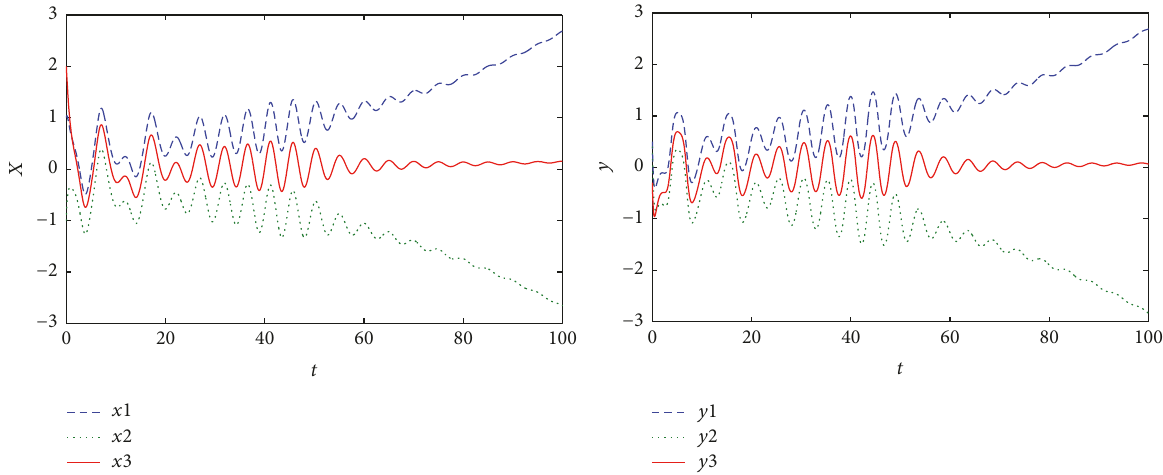
Figure 4: Divergence of three coupled Duffing systems for 𝑎 = 0.4 , 𝑏 = 0.35 , 𝑐 = 0.3 , and 𝑑 = 0.2 .